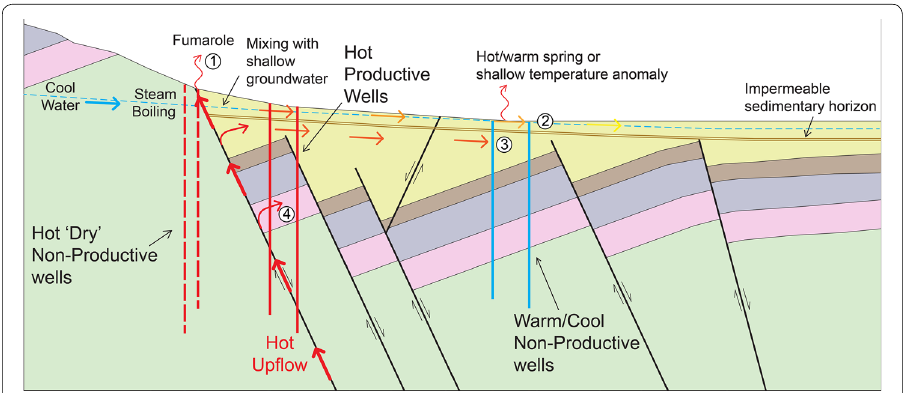
Fig. 2 Conceptual cross section of fault-controlled geothermal upwelling in the western USA (modified from Richards and Blackwell 2002). Geothermal upwelling from depth occurs along steeply dipping faults, but the location(s) of surficial geothermal features (e.g., fumaroles, hot springs) or shallow temperature anomalies may not necessarily indicate the location of the fault(s) that host upwelling. (1) Fluids upwell directly to the surface and effuse along the trace of the fault and/or (2) intersect a shallow aquifer, masking the thermal/ geochemical signature, and flow out distal to the trace of the upwelling fault. (3) Upwelling fluids are capped by impermeable sedimentary layers in the subsurface, leaving no expression of geothermal fluids at the surface at all, (4) or upwelling fluids charge a permeable stratigraphic reservoir in the